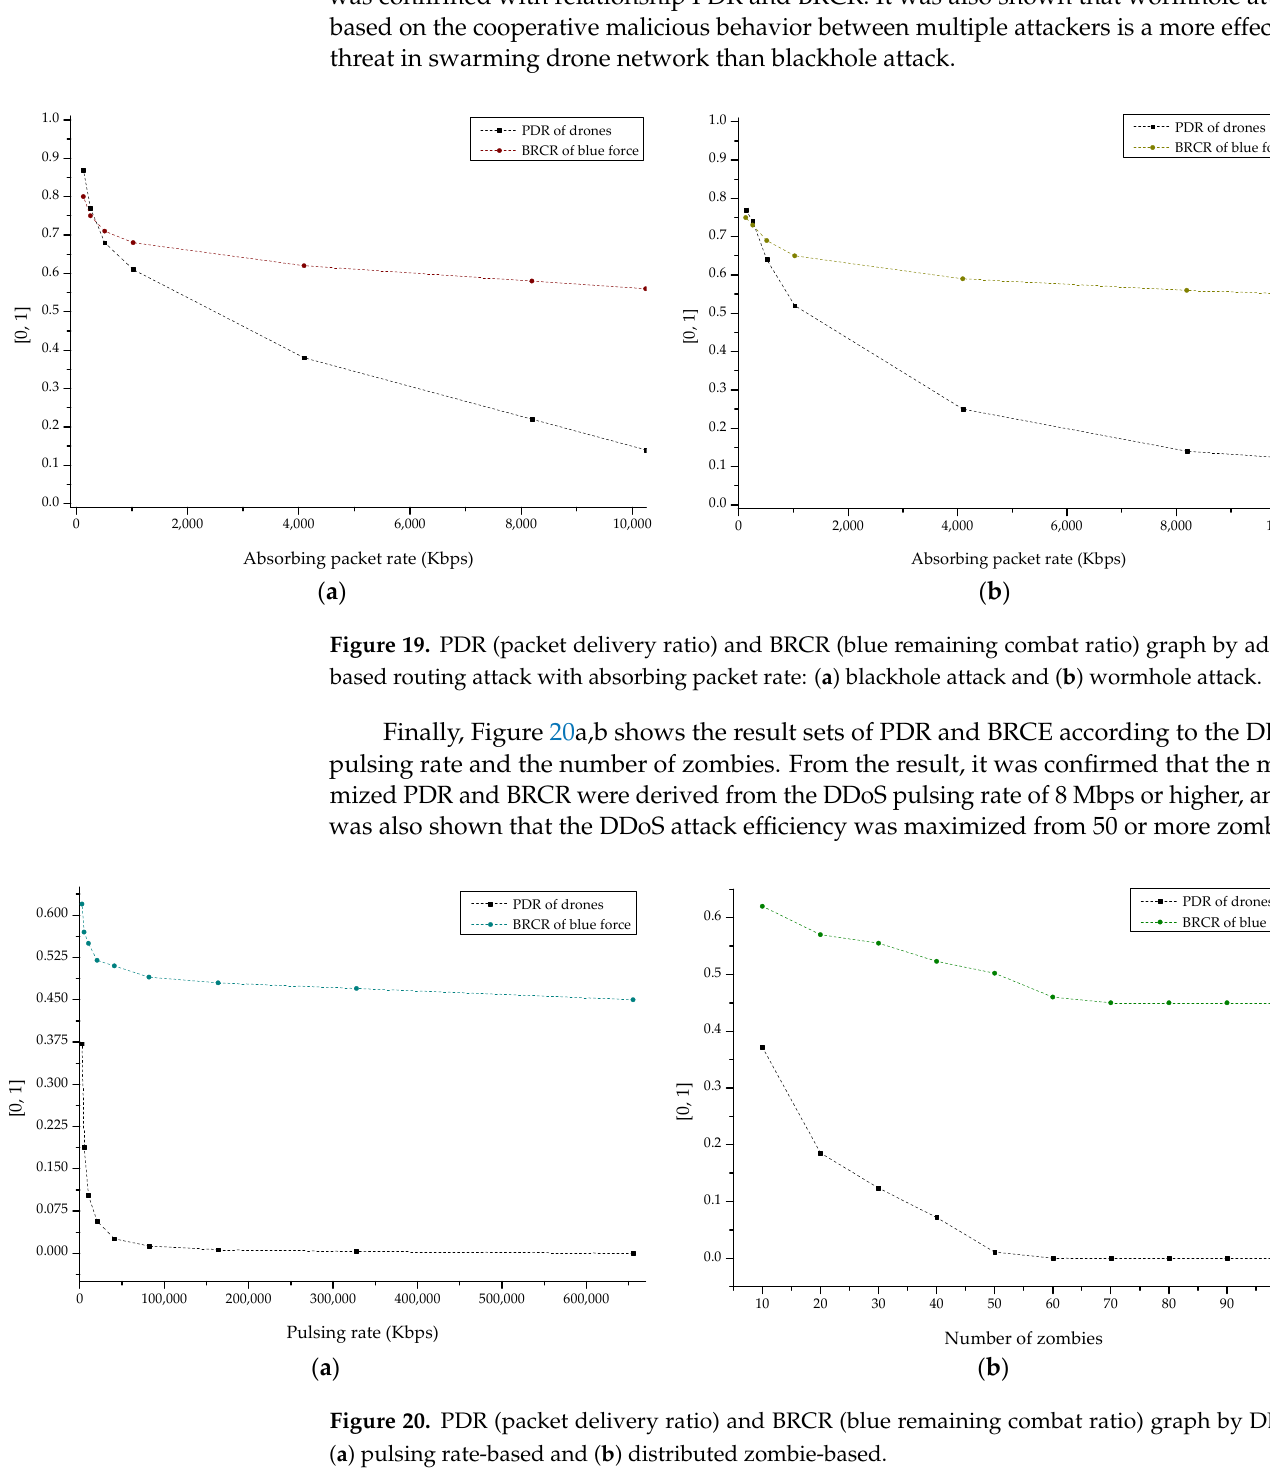
Figure 20. PDR (packet delivery ratio) and BRCR (blue remaining combat ratio) graph by DDoS: ( a ) pulsing rate-based and ( b ) distributed zombie-based.